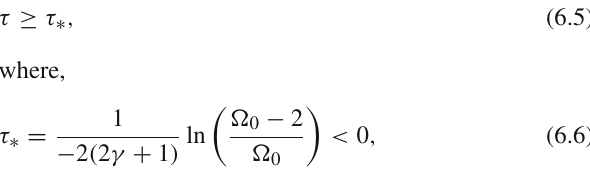
bounded and approaches zero, even if the functions H (τ) and (cid:4) (τ) take arbitrary large